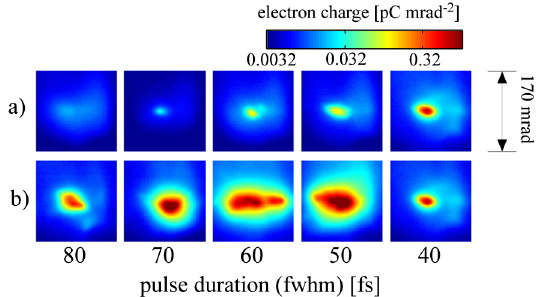
FIG. 2. Electron beam profiles for various pulse durations at fixed (cid:1)E and at a plasma density just above the threshold density for injection for 40 fs pulses. The pulse duration was varied by changing the compressor grating separation which introduces a chirp to the pulse: (a) negative chirp; (b) positive chirp.